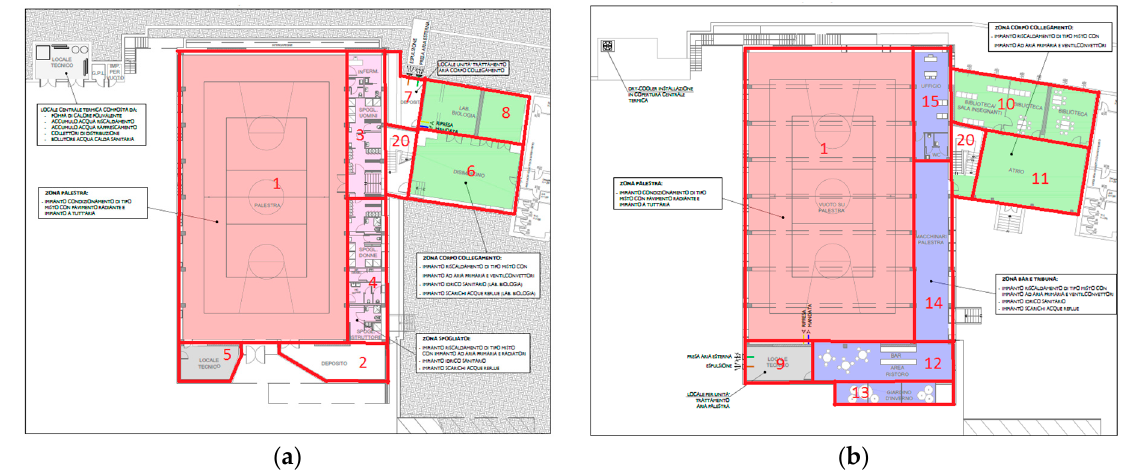
Figure 5. The retrofitting intervention and definition of thermal zones for the ground floor ( a ) and first floor ( b ).